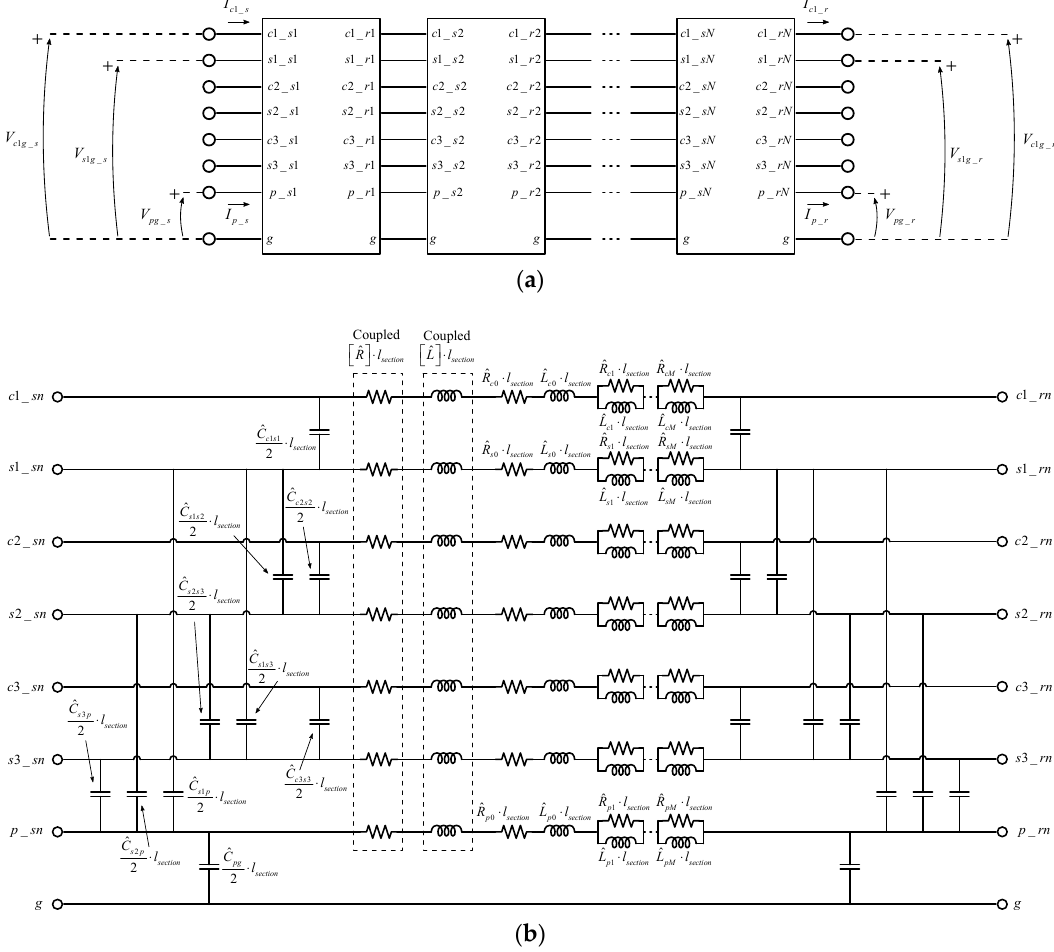
Figure 1. Electrical schematic of the Frequency-Dependent Pi (FDPi) Model. ( a ) Cascaded FDPi sections. ( b ) Detailed schematic of an FDPi section (Capacitances at the right-hand side are equal to the left-hand side, but their names are omitted for simplicity).